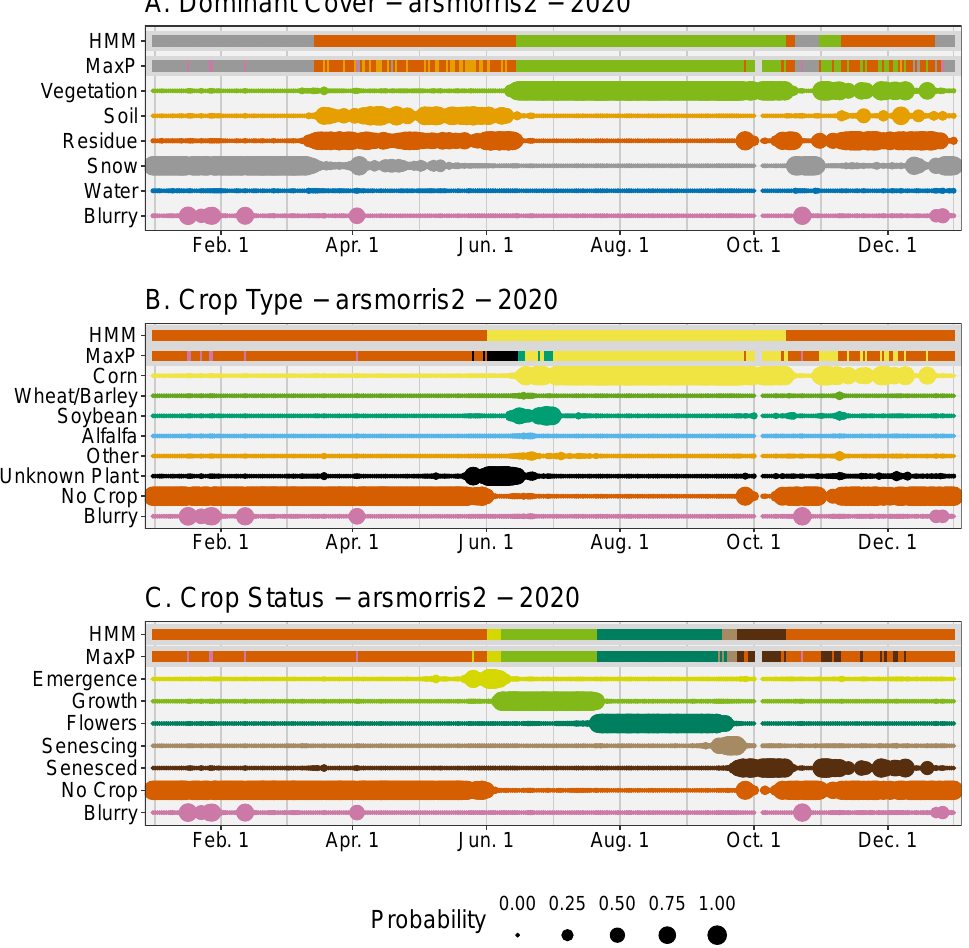
Figure 4. Classification results for the arsmorris2 site for the year 2020. The panels represent the results for the Dominant Cover ( A ), Crop Type ( B ), and Crop Status ( C ) categories. The top two rows of each panel represent the final classification for either the daily maximum probability (MaxP) or the hidden Markov model (HMM). The remaining rows in each panel represent the initial model classification for the respective class, where larger sizes represent higher